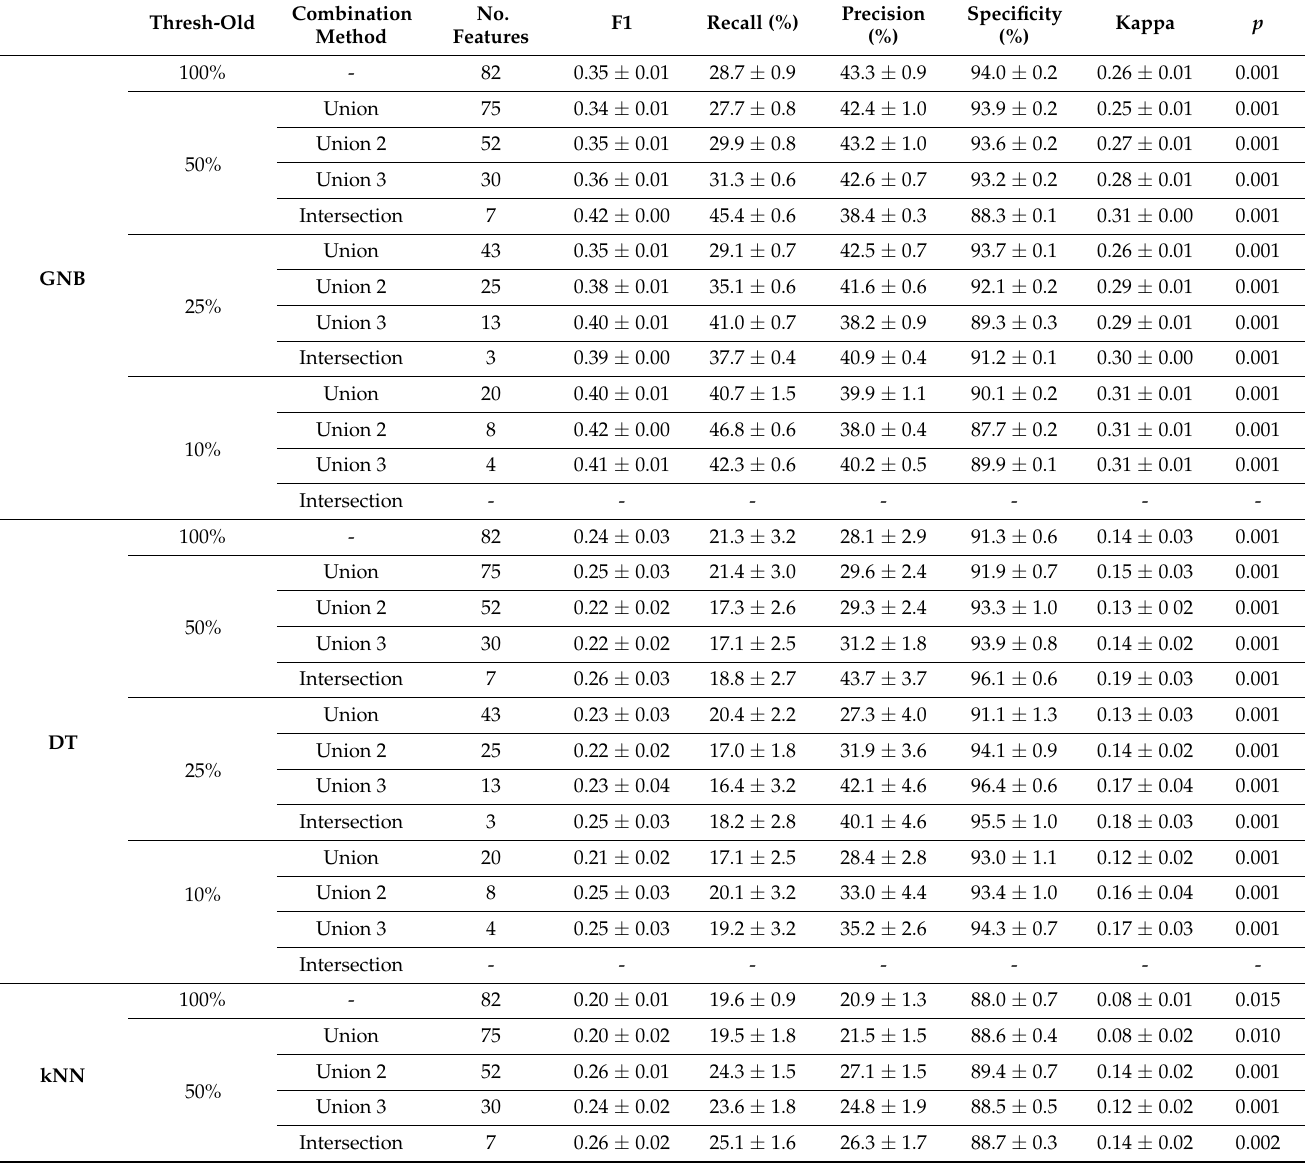
Table A5. Performance of the four classification models on detection fall using GAITRite System normal walking data set ; Gaussian Naive Bayes (GNB); Decision Tree (DT); k-Nearest Neighbor (kNN); Support Vector Machine (SVM); p -value via permutation